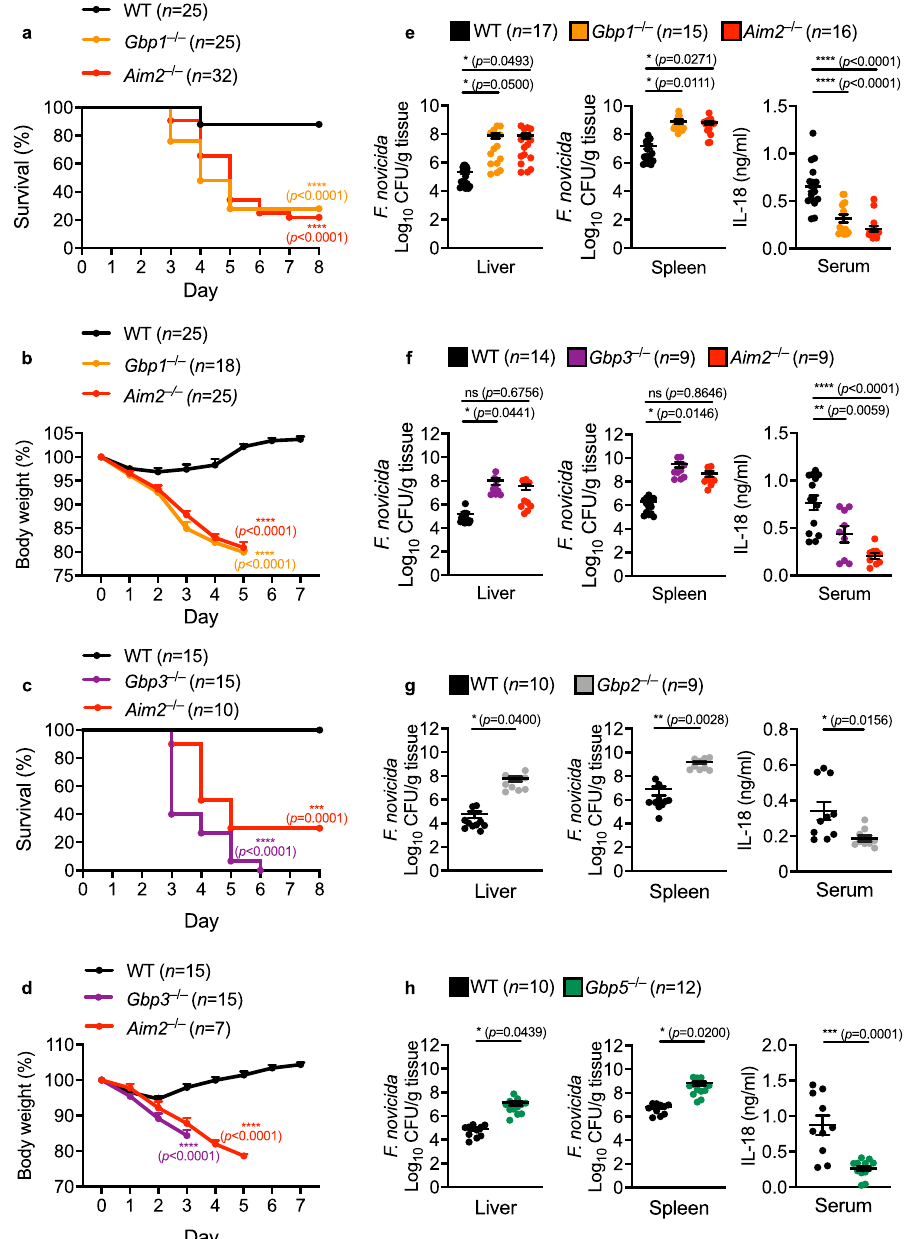
Fig.5|GBP1,GBP2,GBP3andGBP5providehostprotectionagainst F.novicida infection in vivo. a Survival of 7-week-old WT mice ( n =25), Gbp1 – / – mice ( n =25) and Aim2 – / – mice ( n =32) infected subcutaneously with 1.2×10 6 colony-forming units (CFUs) of F. novicida . b Body weight of 7-week-old WT mice ( n =25), Gbp1 – / – mice ( n =18) and Aim2 – / – mice ( n =25) 0 – 7 d after subcutaneous infection with 1.2×10 6 CFUsof F.novicida ,presentedrelativetoinitialbodyweightatday0,setas 100%. c Survival of 7-week-old WT mice ( n =15), Gbp3 – / – mice ( n =15) and Aim2 – / – mice( n =10)infectedsubcutaneouslywith1.2×10 6 colony-formingunits(CFUs)of F.novicida . d Body weight of 7-week-old WTmice( n =15), Gbp3 – / – mice( n =15)and Aim2 – / – mice ( n =7) 0 – 7 d after subcutaneous infection with 1.2×10 6 CFUs of F. novicida , presented relative to initial body weight at day 0,set as100%. e Bacterial burden in the liver (left) and spleen (middle) and concentration of IL-18 in the serum (right) of 7-week-oldWT mice( n =17), Gbp1 – / – mice ( n =15)and Aim2 – / – mice ( n =16)onday3afterinfectionwith6×10 5 CFUsof F.novicida . f Bacterialburdenin